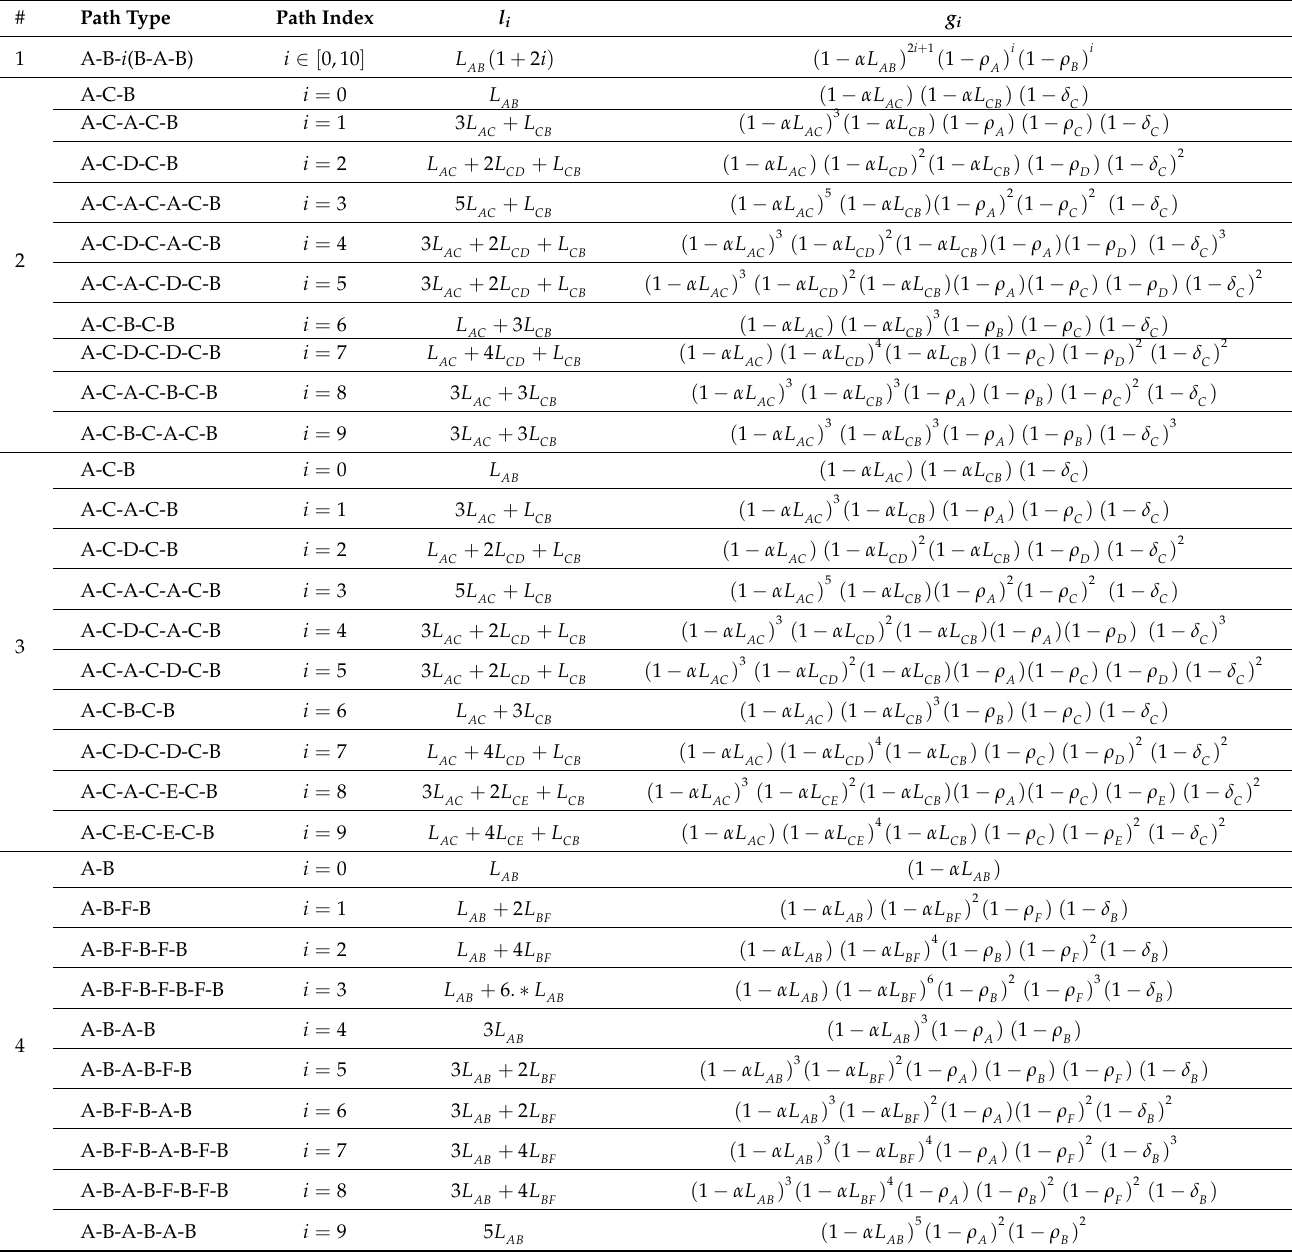
Table 2. Power delay profiles of the ( N = 10) first arrived paths for the different